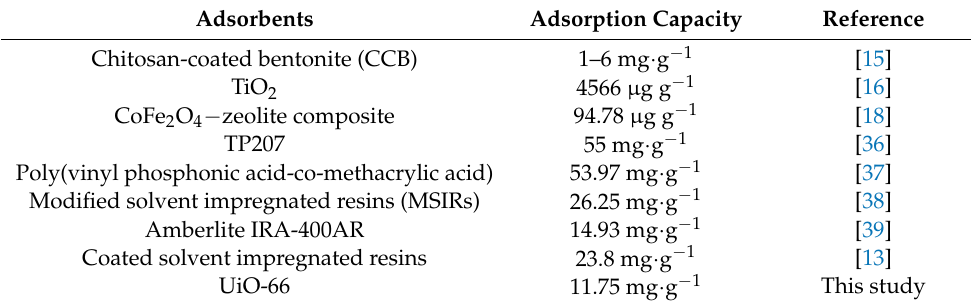
Table 3. A summary table of the adsorption capacities of UiO-66 for In(III) and other adsorbents reported in the previous